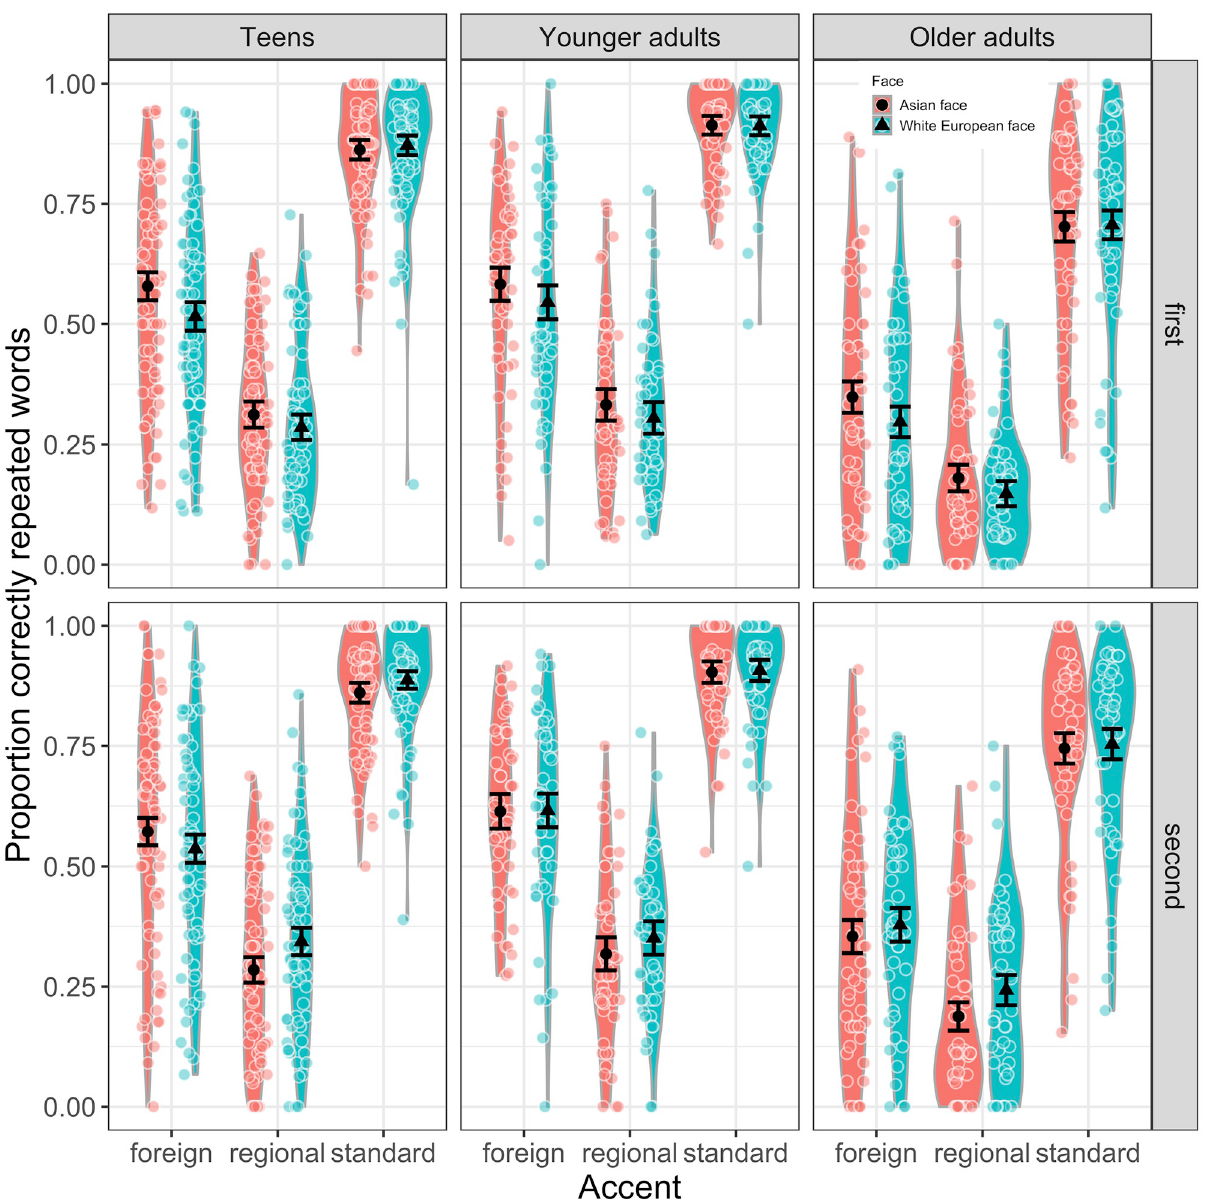
Fig 2. Sentence repetition. Proportion of correctly repeated words in the respective speech context for the first and second half of the experiment, and for each listener group. Black dots represent the overall means and the colored dots show the individual participant means. The violin plots depict probability density, i.e. the wider the shaded area, the more data is located in that area. Error bars represent 95% confidence intervals.